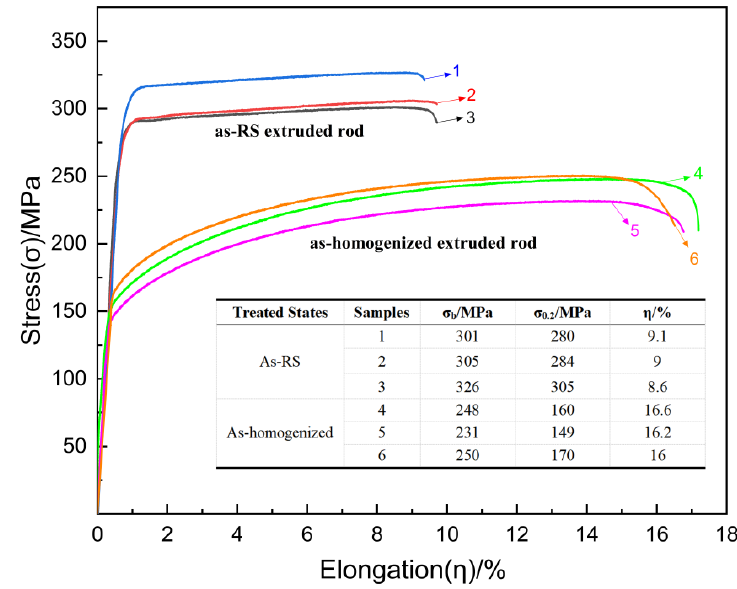
Figure 9. Engineering tensile stress-strain curves of as-homogenized and as-RS AZ31 extruded rods. According to the Hall-Petch relationship, σ 0.2 = σ 0 + kd −1/2 , it can be concluded from